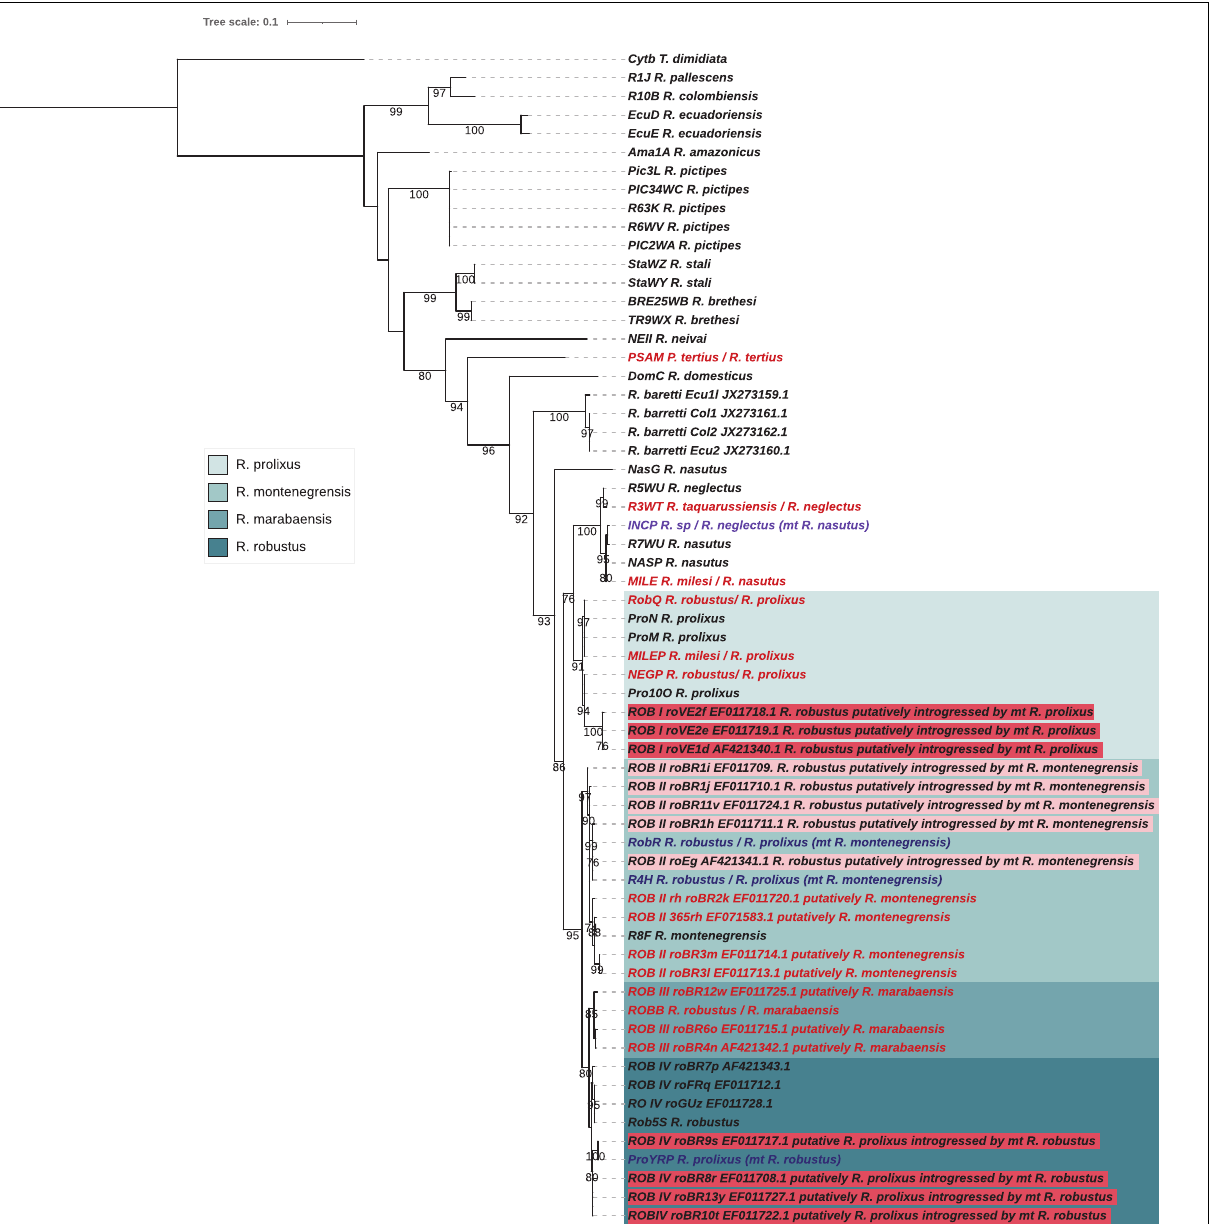
FIGURE 7 | Phylogenetic inferences and interpretation for the Cytb gene for Rhodnius species with the Maximum Likelihood (ML) method including Monteiro et al. (2003) samples. The statistical supports (1,000 replicates SH-aLRT) are indicated on the nodes. T. dimidiata was used as outgroup. For the dataset of this study, introgressed species inferred from the nuclear phylogeny (see Figure 5 ) are indicated in purple, misidentified species in red. For Monteiro et al. (2003) samples, based on the inferences made for our samples, we proposed putative introgressed species, highlighted in the tree and putative misidentifications for some others, indicated in red. For ROB I clade clustered with R. prolixus samples and composed of Venezuelan R. robustus samples, they putatively are R. robustus introgressed by mitochondrial DNA from R. prolixus. For ROB II clade, some samples clustered with the R. montenegrensis could be synonymized with R. montenegrensis while the other could be R. prolixus introgressed by mitochondrial DNA from R. montenegrensis. For the ROB III clade, specimens clustered with R. marabaensis and could be synonymize as R. marabaensis. For the ROB IV clade, some samples are clustered with R. robustus while others could be R. prolixus introgressed by mitochondrial DNA from R. robustus